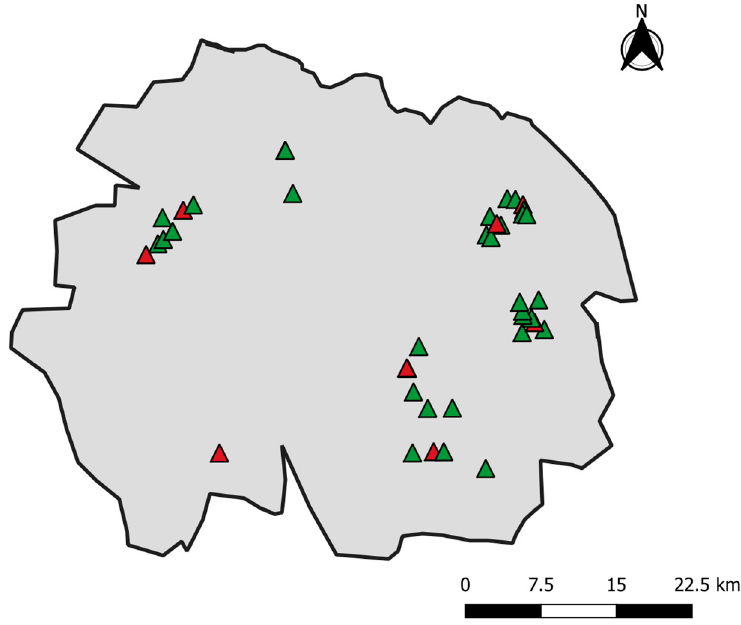
Figure 3. Training and testing plots of single temporal point.